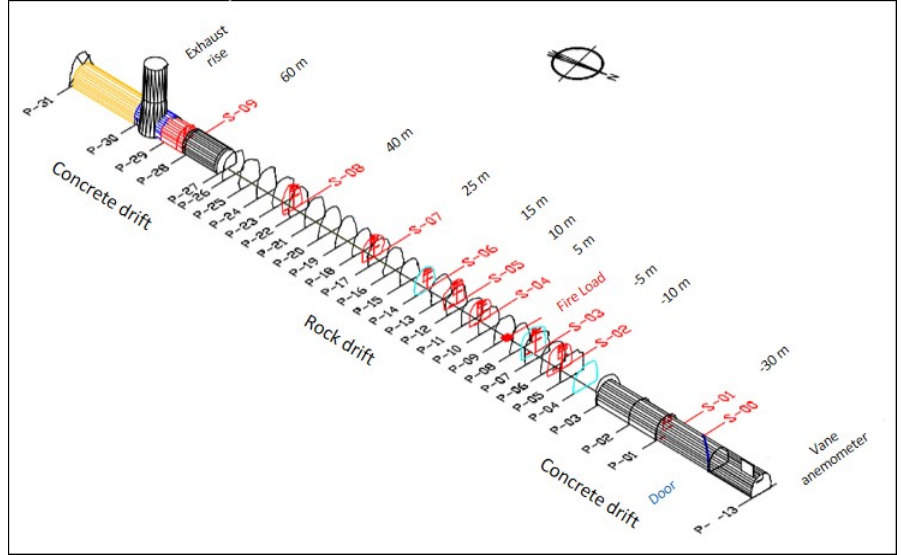
Figure 2. Scheme of the testing drift.